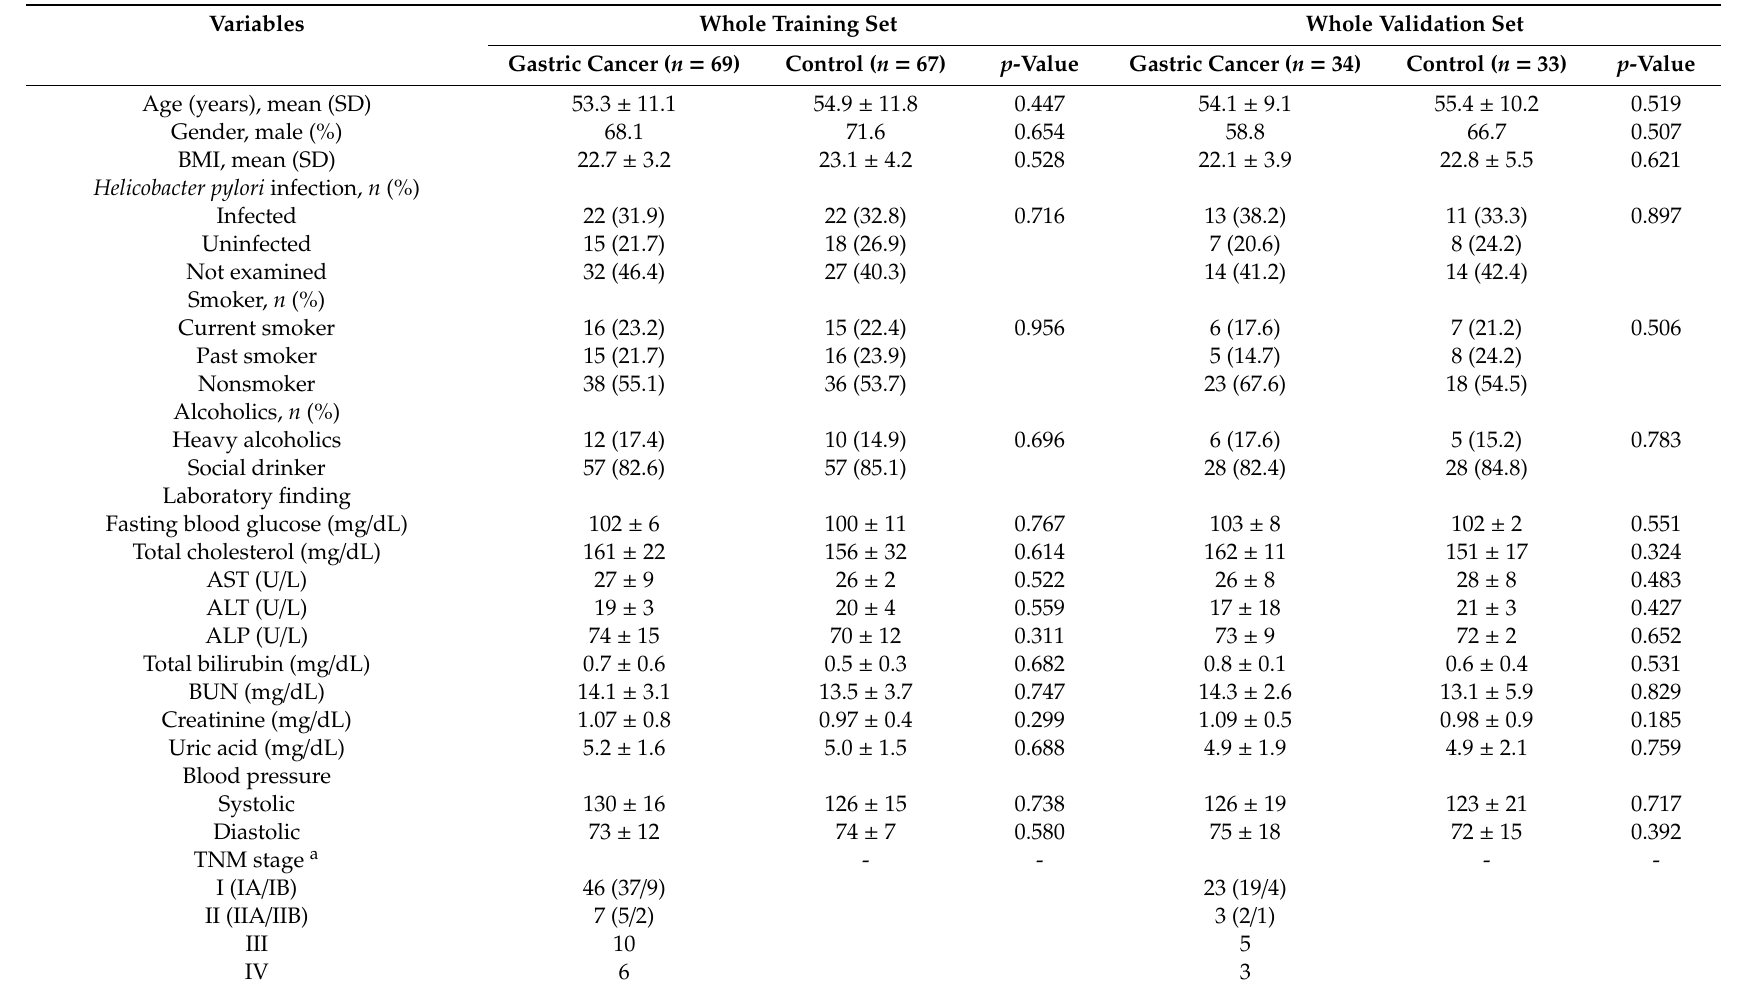
Table 1. Clinicopathologic characteristics of the study